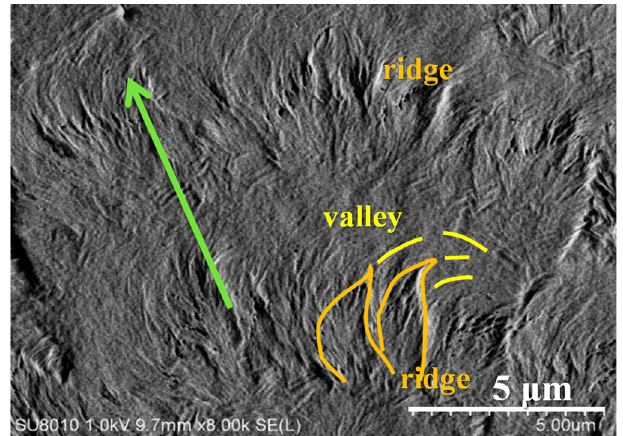
Figure 7. Zoom-in SEM micrograph of the top surface of PPDO/PVPh (75/25) blend crystallized at T c = 78 °C. (Green arrows indicating the radial direction.).